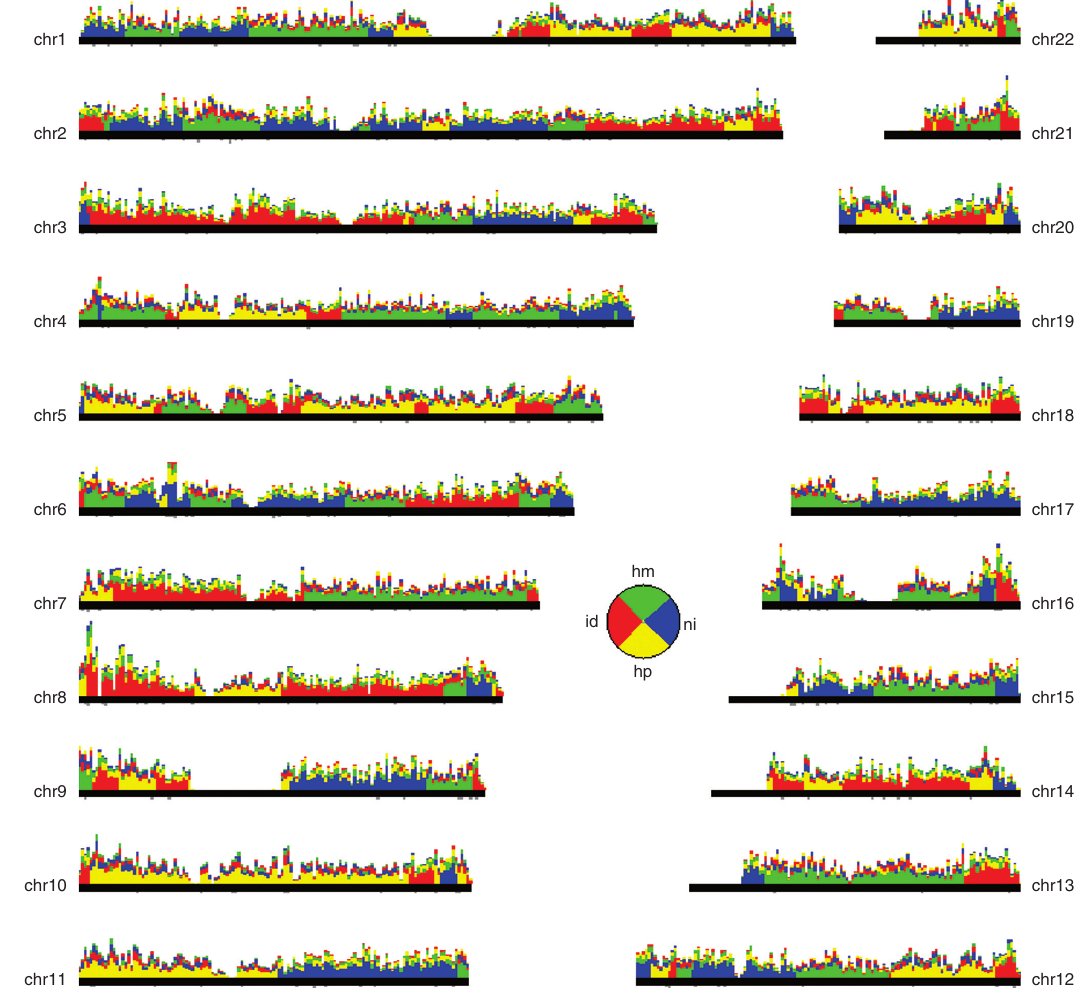
Figure 4. Inheritance State Consistency Analysis (ISCA) plot for the Father-Mother-Son-Daughter quartet, depicting for each autosome the number of informative SNPs supporting each of the four possible inheritance states: “identical” (“id”, red), “haploidentical maternal” (“hm”, green), “haploidentical paternal” (“hp”, yellow) and “nonidentical” (“ni”, blue). SNPs consistent with two inheritance states contribute 0.5 weight to each. SNP counts are binned in non-overlapping 1 Mb windows; within each window, the four inheritance states are sorted by decreasing level of support. Regions without support typically overlap centromeric repeats and heterochromatic regions. Pie chart inset: fraction of the genome observed in each inheritance